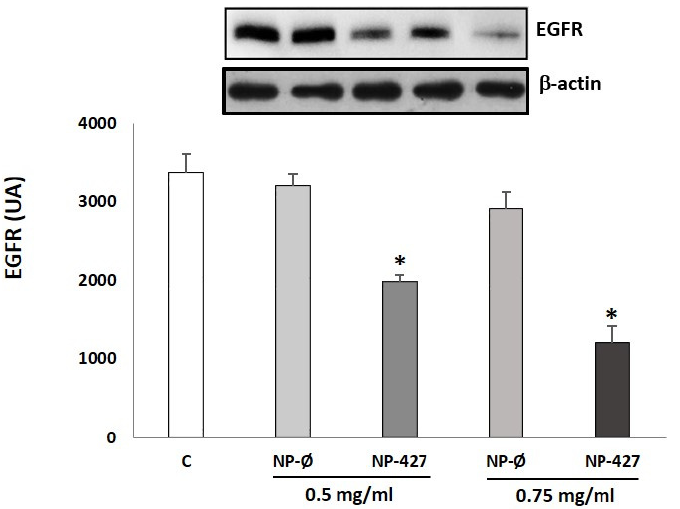
Figure 10. NP-427 reduces EGFR levels in the FaDu cell culture. FaDu cells treated with C (control), NP-Ø (unloaded NPs, 0.5 and 0.75 mg/mL), and NP-427 (PHT427-loaded NPs, 0.5 and 0.75 mg/mL) for 24 h. The densitometric data of Western blot for EGFR represent the mean ± SEM of arbitrary units (AU). Loading control: β -actin. * p < 0.05 vs. C and their respective NP-Ø group ( n = 4).